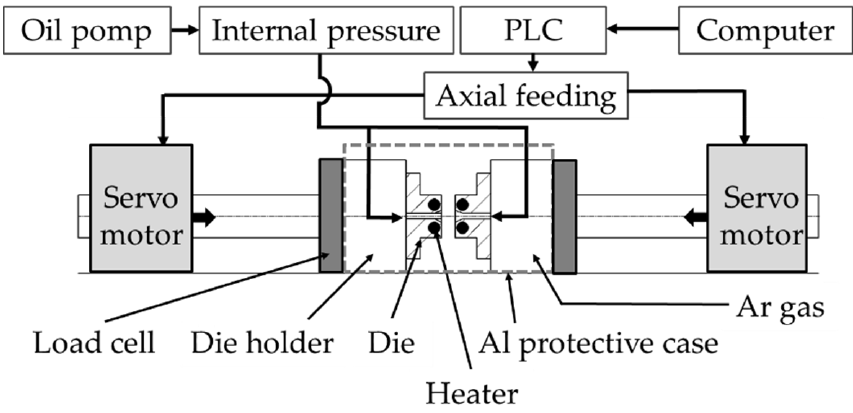
Figure 2. Schematic of the small warm hydroforming system.